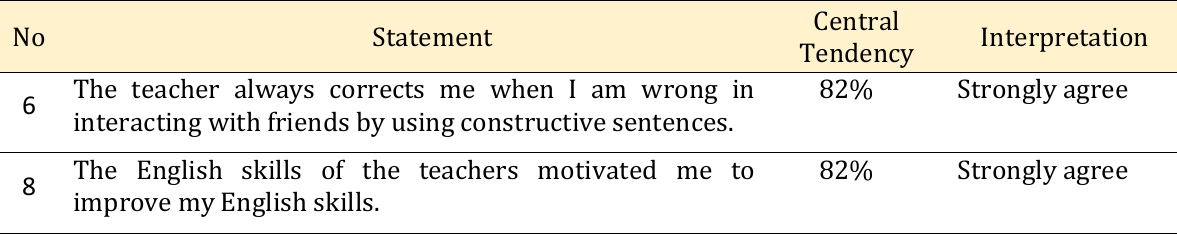
Table 6. Statement 6,8 questionnaire and interview data